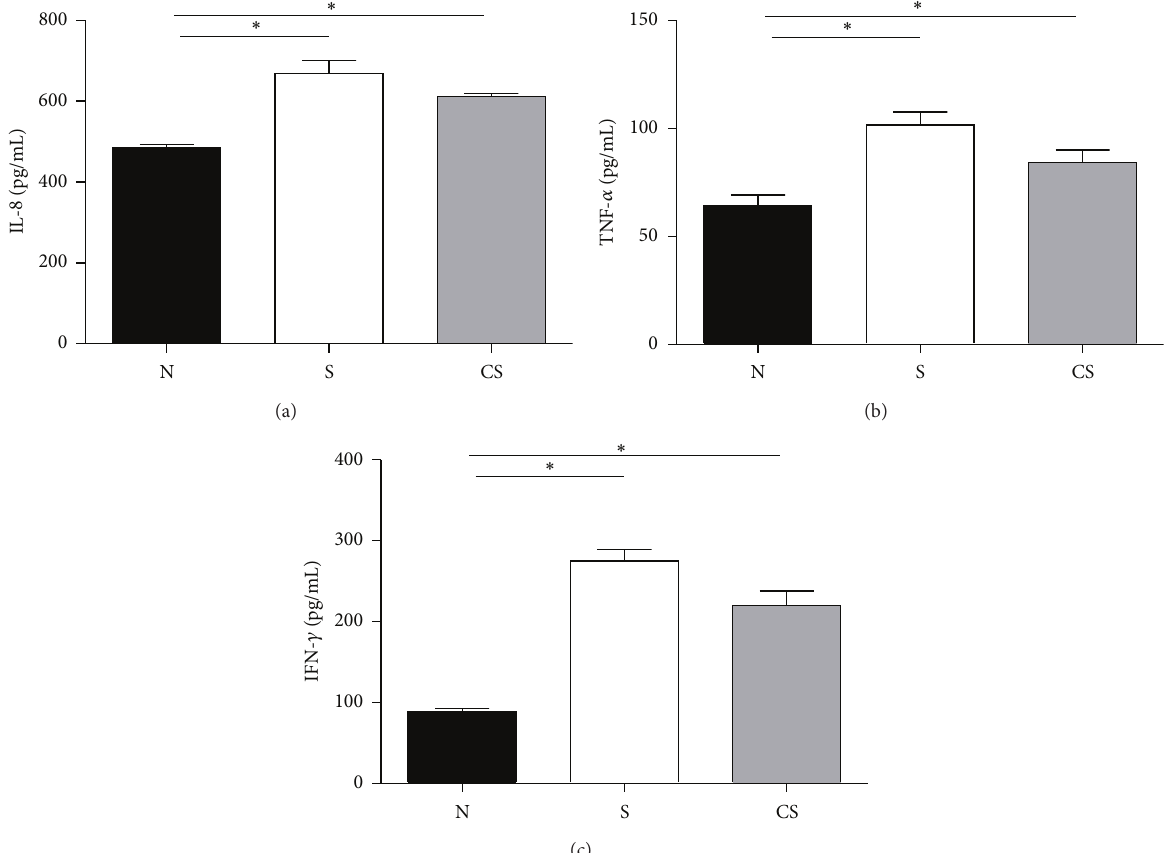
Figure 2: Elevated levels of interleukin (IL)-8, TNF- 𝛼 , and IFN- 𝛾 are not reversible after smoking cessation. Protein levels of IL-8, TNF- 𝛼 , and IFN- 𝛾 in BALF of nonsmoke mice, smoke-exposed mice, and smoke cessation mice were measured by using ELISA. (a) Protein levels of IL-8 in BALF, (b) protein levels of TNF- 𝛼 in BALF, (c) protein levels of IFN- 𝛾 in BALF. Results are expressed as pg/mL (mean ± SEM). 𝑛 = 10 animals/group; ∗ 𝑃 < 0.001